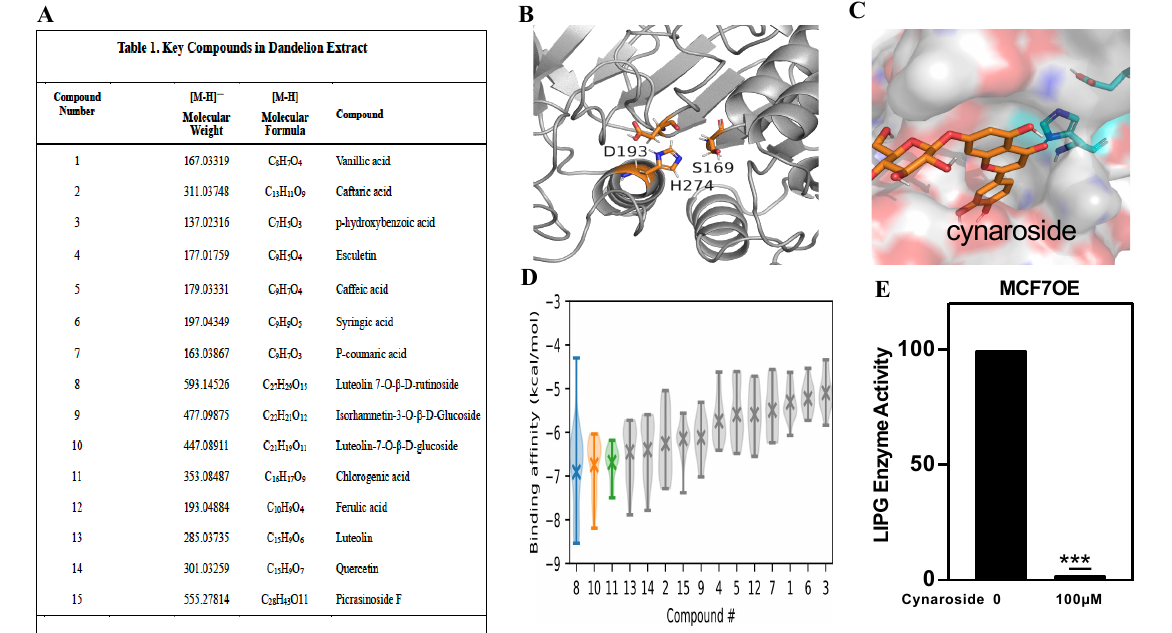
Figure 4. Identification of cynaroside as a new LIPG inhibitor. ( A ) UHPLC-ESI-Orbitrap MS/MS analysis was used to identify chemical components in dandelion extract [49]. The key components are summarized in the Table 1. ( B ) Zoomed-in view of the active-site binding pocket in LIPG. The catalytic triad (Ser169, Asp193, and His274) is shown in the stick representation. ( C ) Binding poses of luteolin-7-glucoside (cynaroside). ( D ) Estimated binding affinities of the 15 active compounds from the dandelion extract. The compound numbers (x axis) correspond to the compound numbers in ( A ). The binding affinities of 9 poses in 11 snapshots (taken from the last 100 ns of simulation) are shown in a violin plot. The median value is shown as a cross. Data for the top three compounds, 8 (luteolin 7-O-beta-rutinoside), 10 (cynaroside), and 11 (luteolin) are colored blue, orange, and green, respectively. ( E ) LIPG-overexpressing MCF7 cells (MCF7OE) were treated with cynaroside. The phospholipase activity of LIPG was analyzed for 20 min with 1 cycle/min as we previously described [10]. *** p <